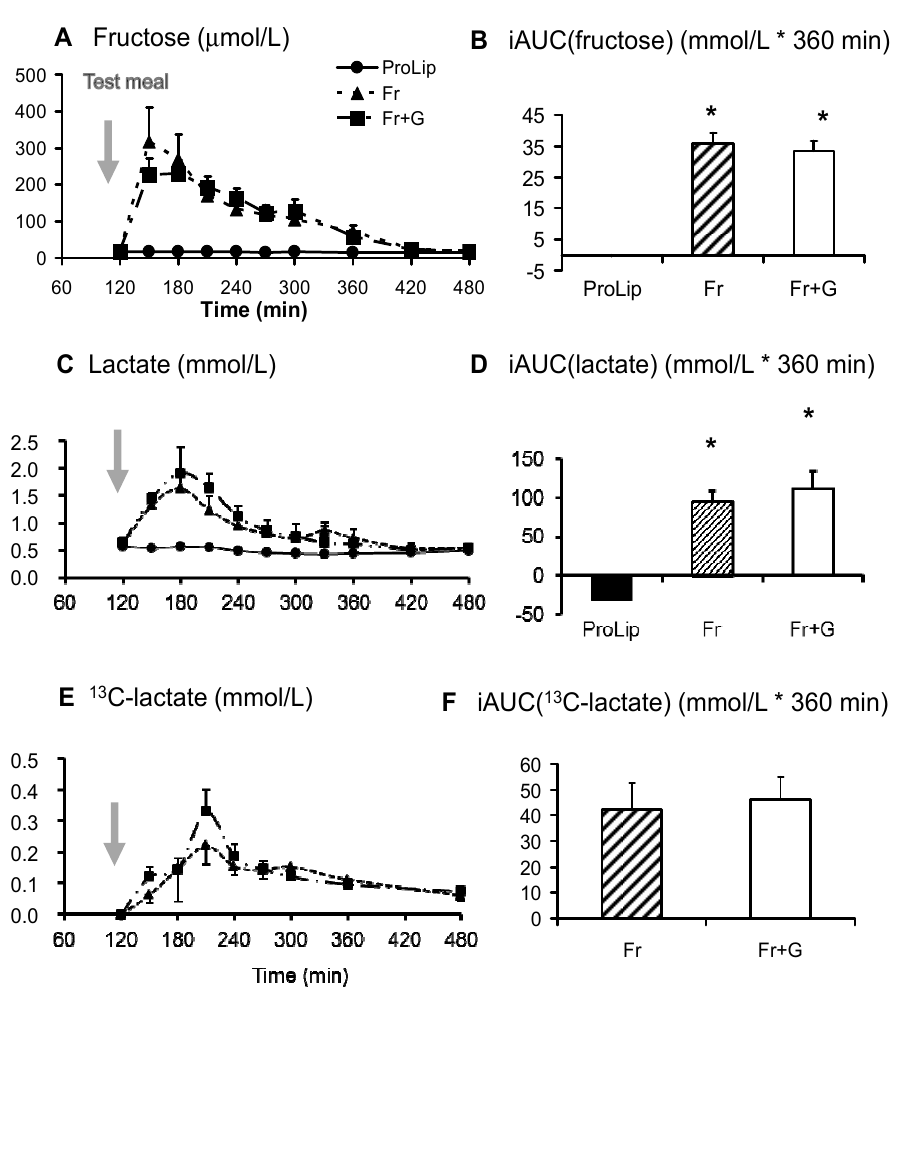
Figure 3. Plasma fructose, lactate and 13 C-lactate responses to test meal ingestion. Time course for plasma fructose ( A ), lactate ( C ) and 13 C-lactate concentrations ( E ) and their corresponding iAUC ( B , D and F ) ( n = 8). * p < 0.05 vs . ProLip; $ p < 0.05 vs .